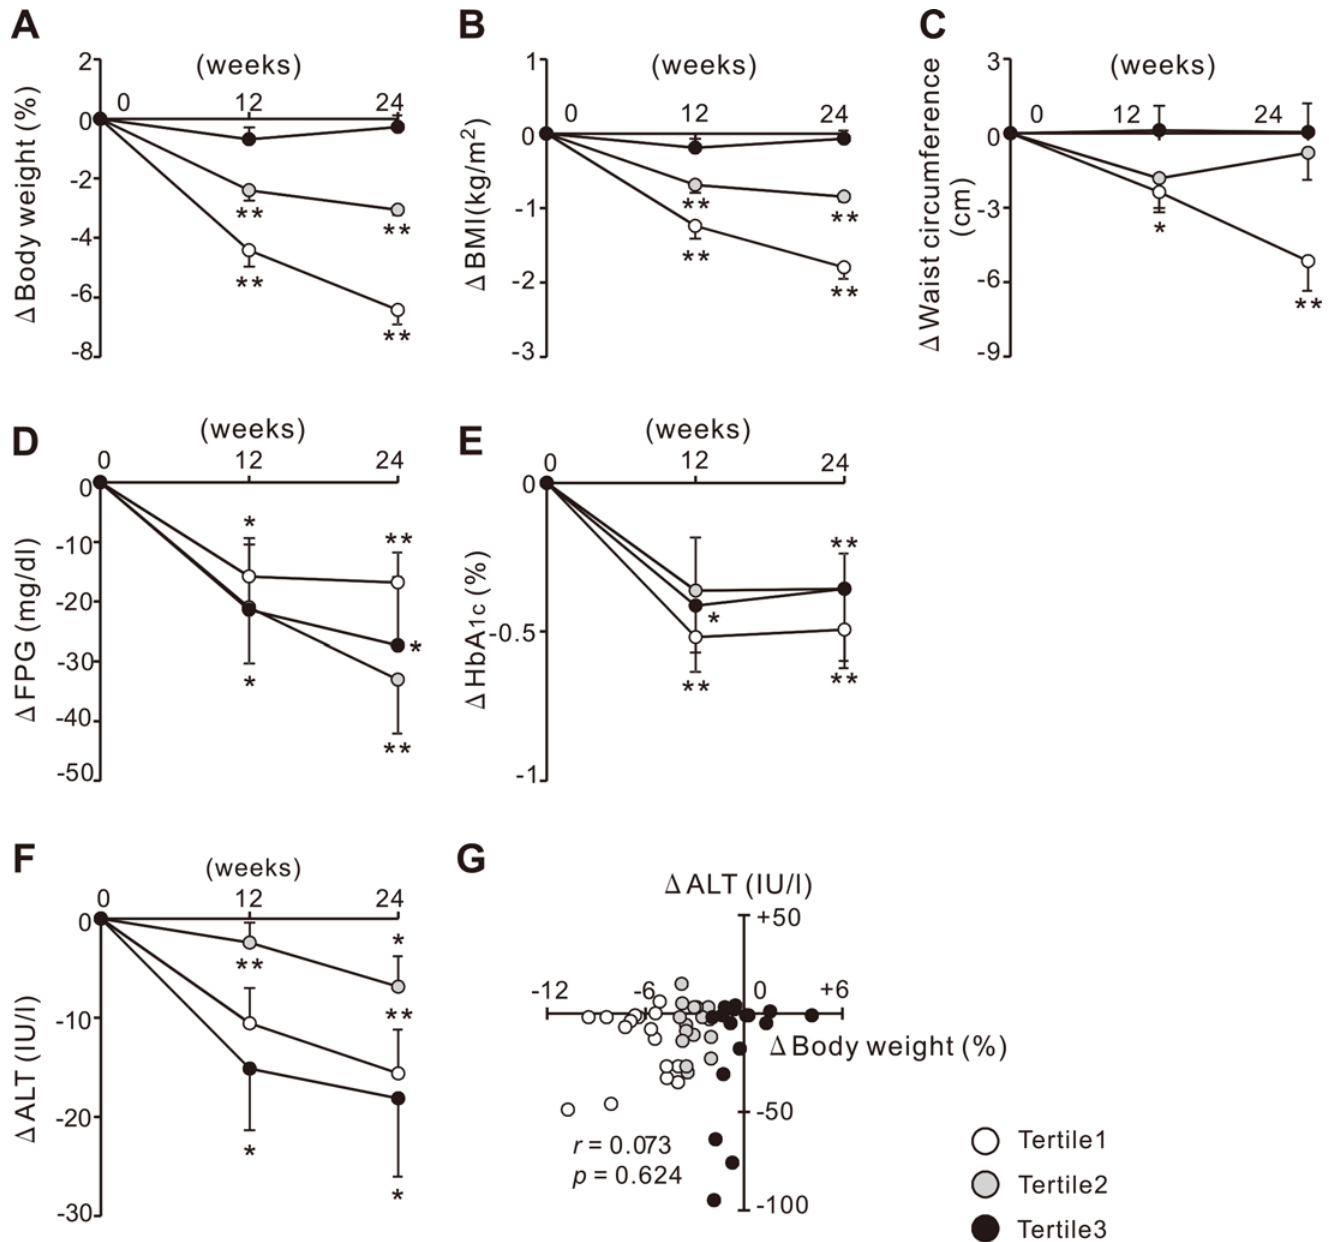
Fig 5. Changes in metabolic parameters and serum ALT levels in patients with T2DM during 24 weeks of ipragliflozin treatment. Changes in (A) body weight, (B) BMI, (C) waist circumference, and levels of (D) FPG, (E) HbA 1c , and (F) serum ALT in patients with T2DM during 24 weeks of ipragliflozin treatment. (G) Correlation between changes in serum ALT levels and body weight after 24 weeks of ipragliflozin treatment. * p < 0.05, ** p < 0.01 vs